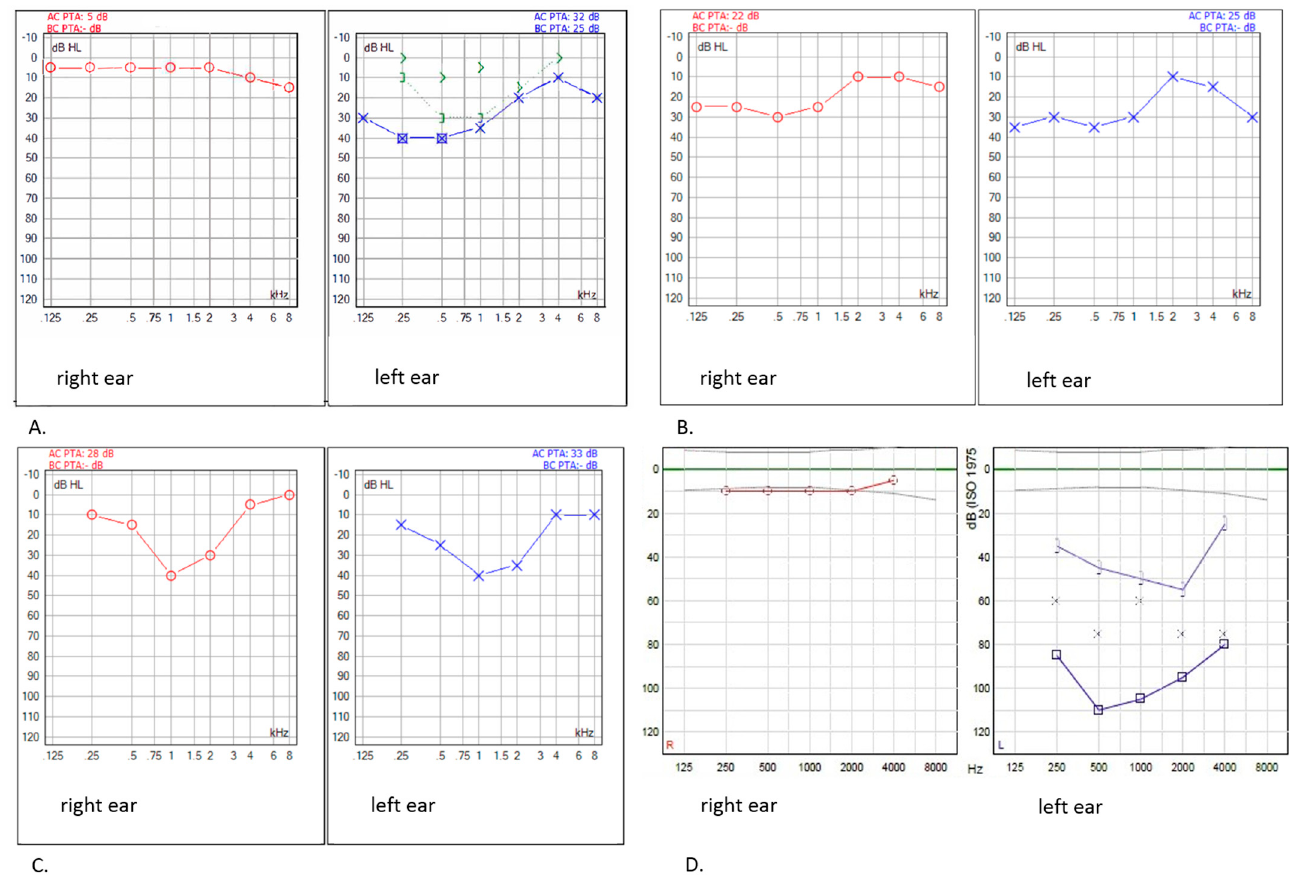
Figure 1. Patterns of hearing loss (HL) as shown per pure-tone audiogram in survivors with a left nasopharyngeal RMS ( A ), right nasopharyngeal RMS ( B ), right orbital RMS ( C ), and RMS in the left ear canal ( D ). Low-frequency HL with a mild HL/normal hearing function in higher frequencies is observed in survivor ( A ) left ear, survivors ( B , C ) both ears, and survivor ( D ) left ear.